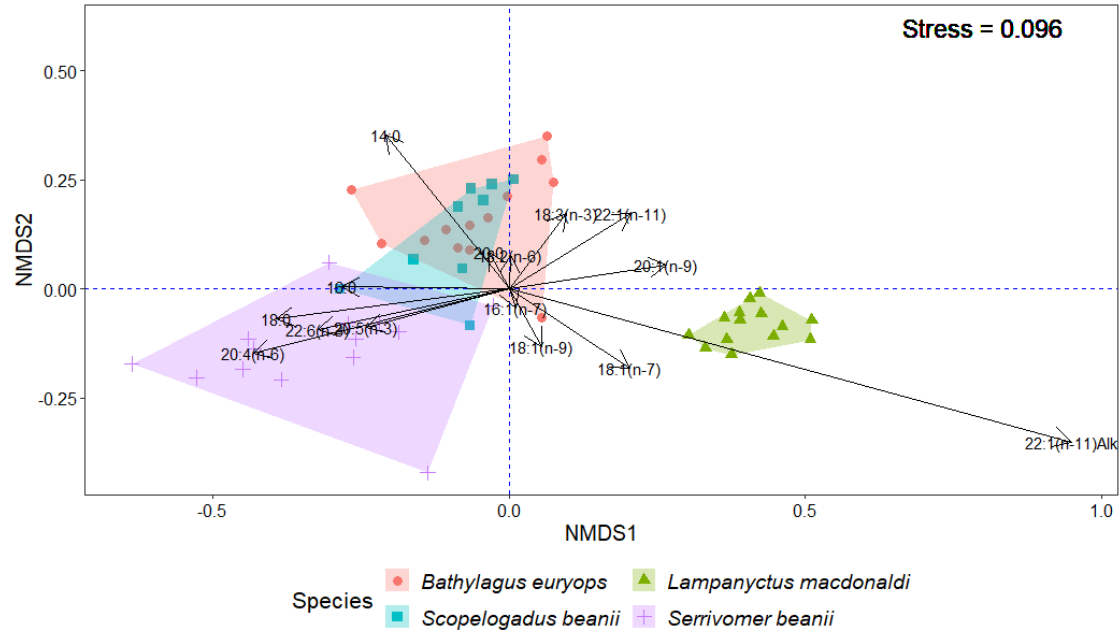
Figure 8. NMDS ordination of individual fatty acids in muscles of mesopelagic fish species ( Bathylagus euryops , Lampanyctus macdonaldi , Scopelogadus beanii , Serrivomer beanii ) living at different depths in the Irminger Sea (North Atlantic).